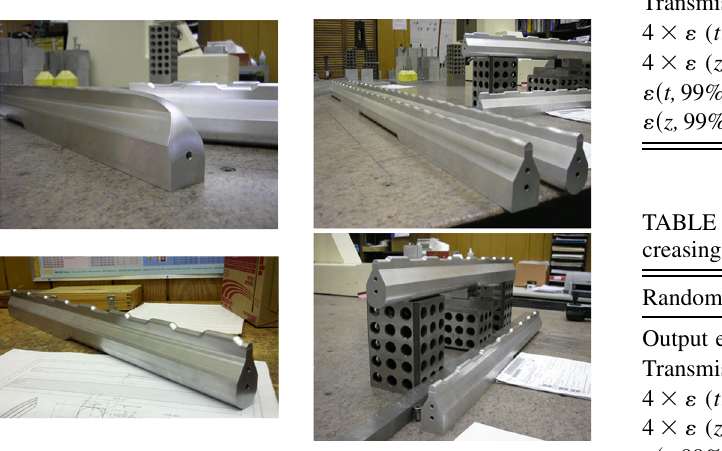
FIG. 15. Aluminum models of vane tip modulation for all RFQ segments.